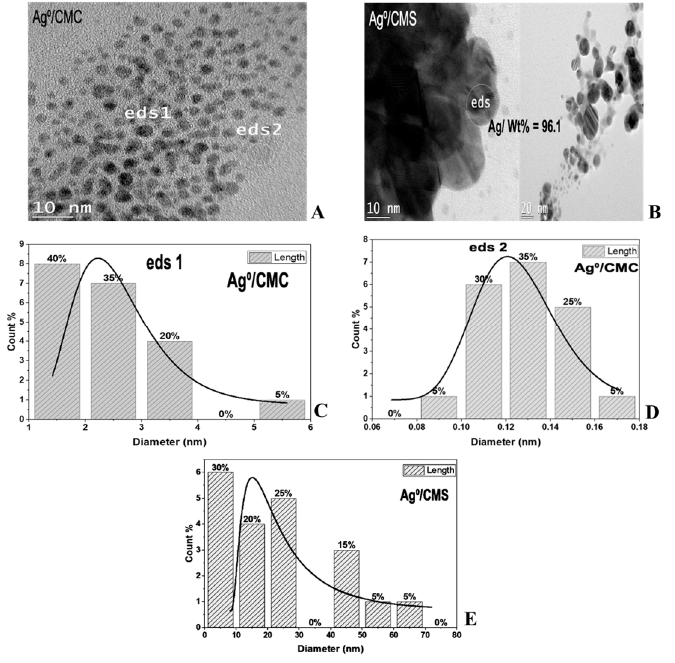
Figure 4. TEM images ( A , B ) and Ag 0 particle size distribution in CMC ( C , D ) and CMS ( E ).